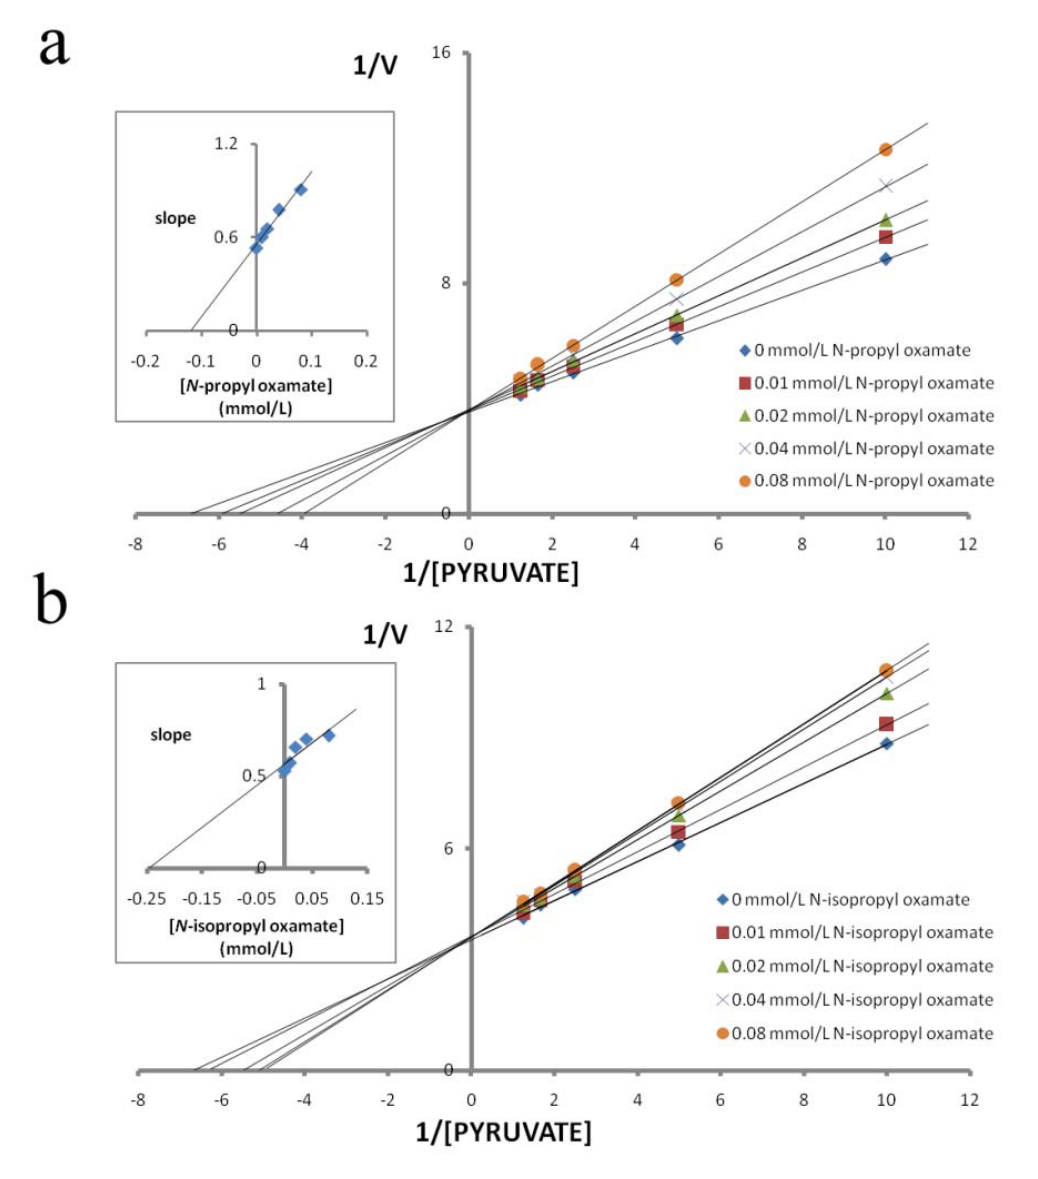
Figure 2. Effect of pyruvate on the inhibitory activity of N- propyl oxamate and N- isopropyl oxamate on plateau pika LDH-B 4 . Reciprocal values of V were calculated taking the reciprocal values of △ 340 nm/min, plots of reciprocal reaction velocity versus reciprocal pyruvate concentration at a constant NADH concentration. The concentrations of pyruvate used were 0.1 mmol/L, 0.2 mmol/L, 0.4 mmol/L, 0.6 mmol/L, and 0.8 mmol/L. NADH concentration was kept at 0.15 mmol/L. The Km of LDH-B 4 for pyruvate was 0.172 mmol/L. ( ◆ ) assays with 0 mmol/L, ( ■ ) 0.01 mmol/L, ( ▲ ) 0.02 mmol/L, (×) 0.04 mmol/L and ( ● ) 0.08 mmol/L of N -propyl oxamate or N- isopropyl oxamate. Upper left: determination of Ki from replot of slope values against inhibitor concentrations. The Ki of N- propyl oxamate and were 0.119 mmol/L and 0.248 mmol/L, N- isopropyl oxamate for LDH-B 4